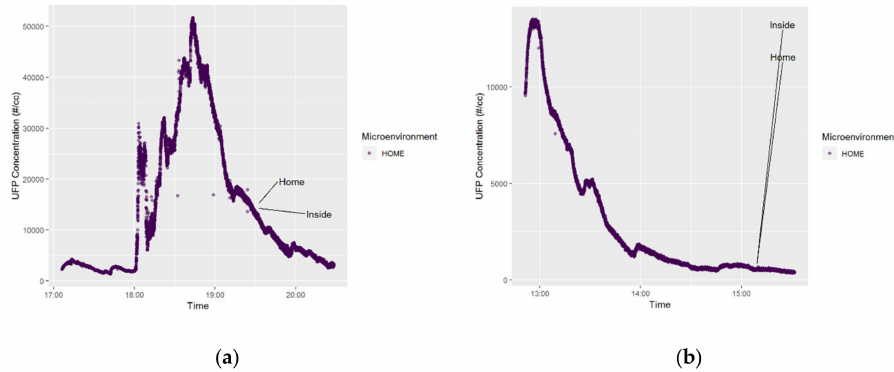
Figure 6. Plots of UFP exposure by microenvironment, participant # 300041 (21–22 June 2018).